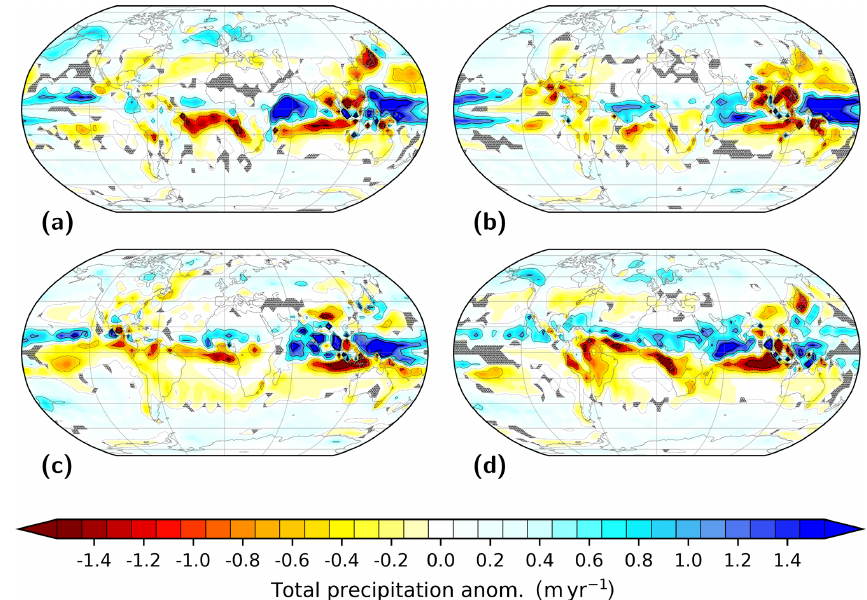
Figure 4. Seasonal mean total precipitation for the PlioMIP2 mid-Pliocene core simulation Eoi400. Shown are anomalies with respect to pre-industrial (simulation E280) for (a) boreal winter (DJF), (b) boreal spring (MAM), (c) boreal summer (JJA), and (d) boreal autumn (SON). Contours illustrate isolines of − 1 . 5myr − 1 (dashed), − 1 . 0myr − 1 (dashed, thin), 0.0myr − 1 (dotted, thin), 0.5myr − 1 (solid, thin), 1.0myr − 1 (solid), and 1.5myr − 1 (solid, thick). In hatched regions the anomaly is insignificant at the 95% confidence interval based on a t test. Total precipitation integrates contributions from large-scale and convective precipitation in the liquid and solid